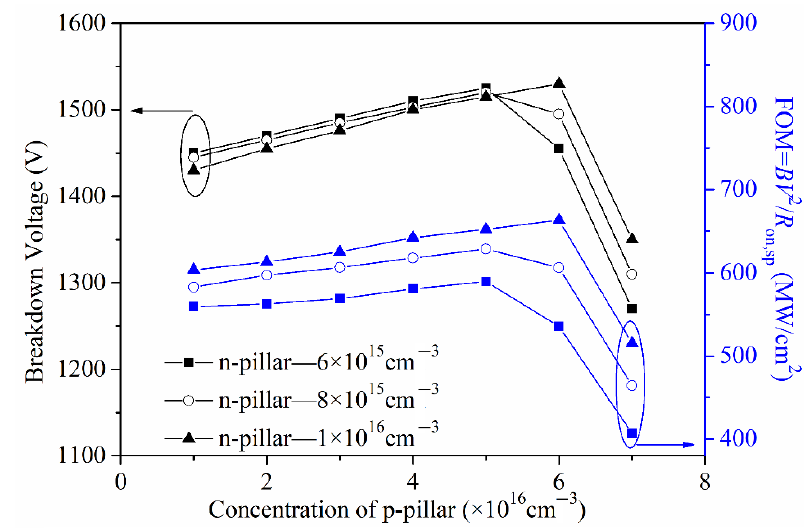
Figure 13. Effect of the concentration of the p-pillar and n-pillar on the BV and FOM.